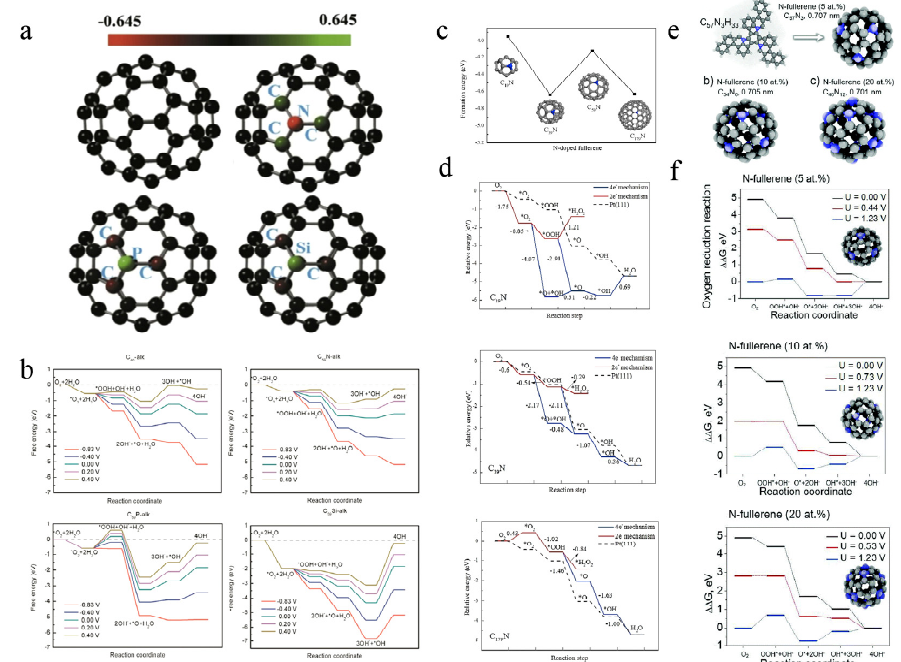
Figure 4. ( a ) Mulliken charge distribution on C 60 , C 59 N, C 59 P, C 59 Si. ( b ) Free-energy diagrams for the reduction of O 2 at different electrode potentials, U, in alkaline medium on C 60 , C 59 N, C 59 P, C 59 Si. Reproduced with permission [55]. Copyright 2017, Elsevier Ltd. ( c ) Calculated formation energies of N-doped fullerenes. ( d ) Relative energy profiles of the possible ORR pathways. Reproduced with permission [56]. Copyright 2017, Elsevier Ltd. ( e ) N-Fullerene of the 5 at% N aromatic precursor with C 57 N 3 H 33 molecules, and azafullerenes doped with N-doping levels of 10 and 20 at%, respectively. ( f ) Gibbs free energy diagrams of ORR in alkaline media with N-doping levels of 5, 10, and 20 at%. Used with permission [57]. Copyright 2017, The Royal Society of Chemistry.